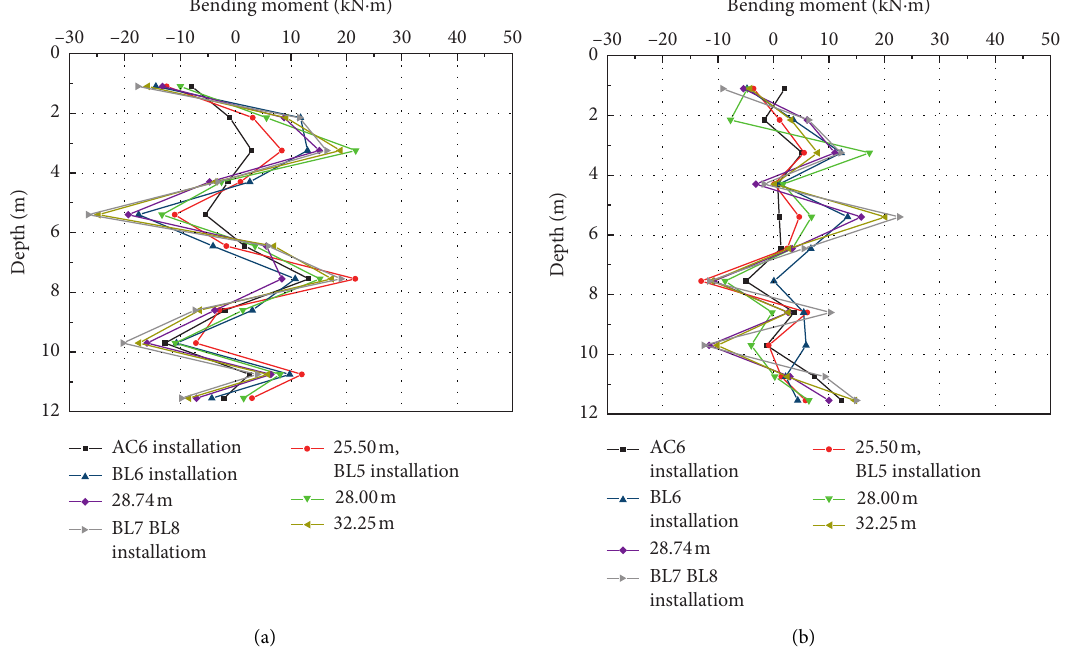
Figure 7: Bending moment of piles during the third-order excavation. (a) Test pile 1. (b) Test pile